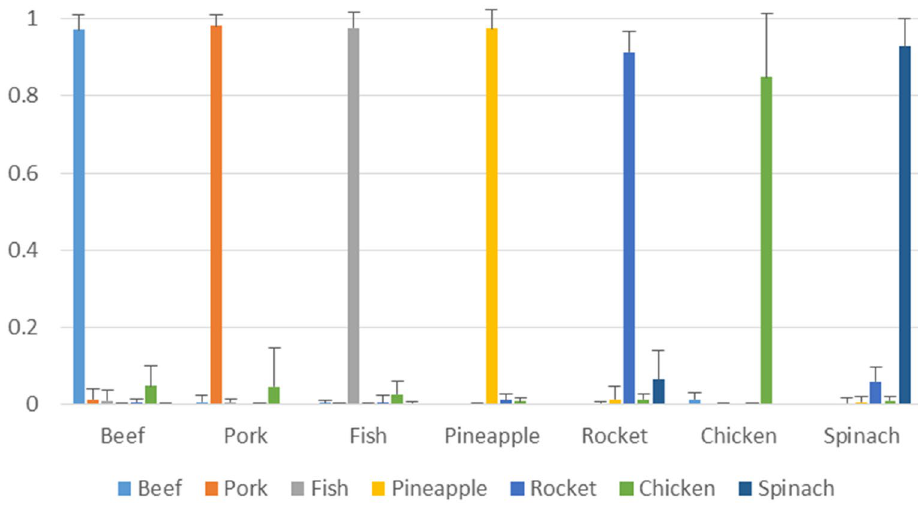
Figure 2. Mean class probabilities for the predictions for each class and the corresponding standard